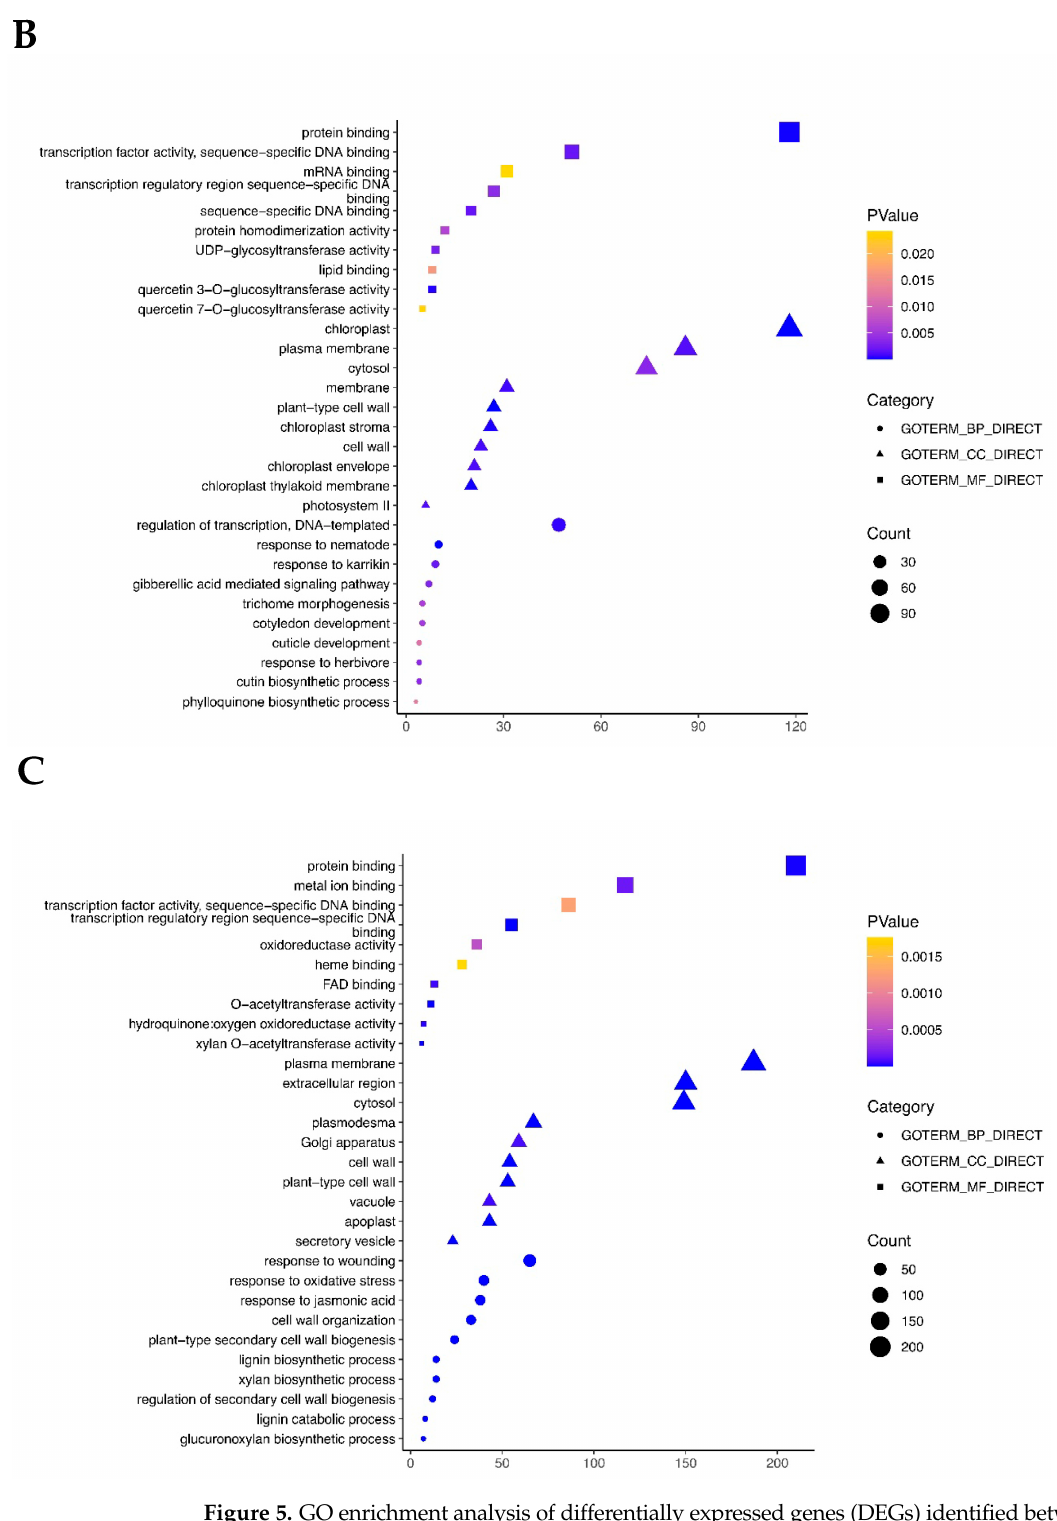
Figure 5. GO enrichment analysis of differentially expressed genes (DEGs) identified between low salt (LS) treatment and no salt control (CK) in two Brassica napus varieties (CH336 and Brutor). ( A ). GO terms of DEGs in the COMMON_LS/CK group. ( B ). GO terms of up-regulated DEGs in the TOTAL_LS/CK group. ( C ). GO terms of down-regulated DEGs in the TOTAL_LS/CK group. The square, triangle, and circle indicate the molecular function (MF), cellular component (CC), and biological process (BP) GO categories, respectively. The pattern size means the number of DEGs enriched in each term. The different pattern colors refers to different p -values of for the enriched GO terms.